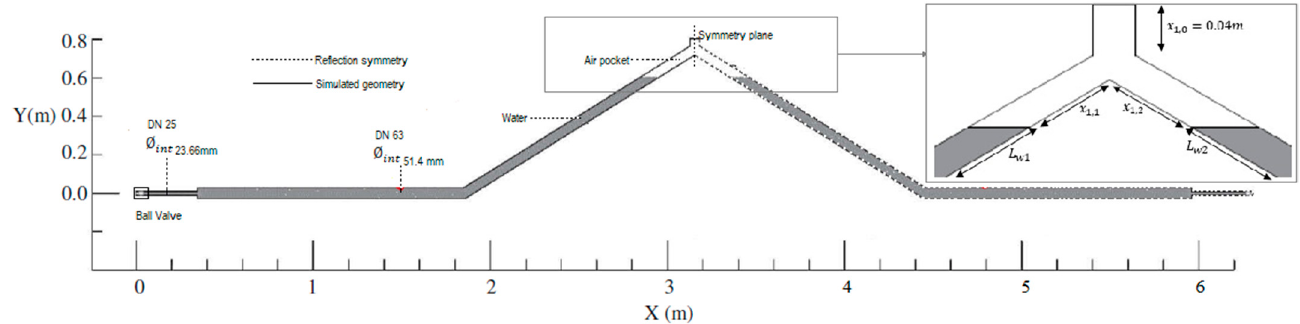
Figure 1. Complete pipeline model with details of lengths for the different behaviours of the study cases.